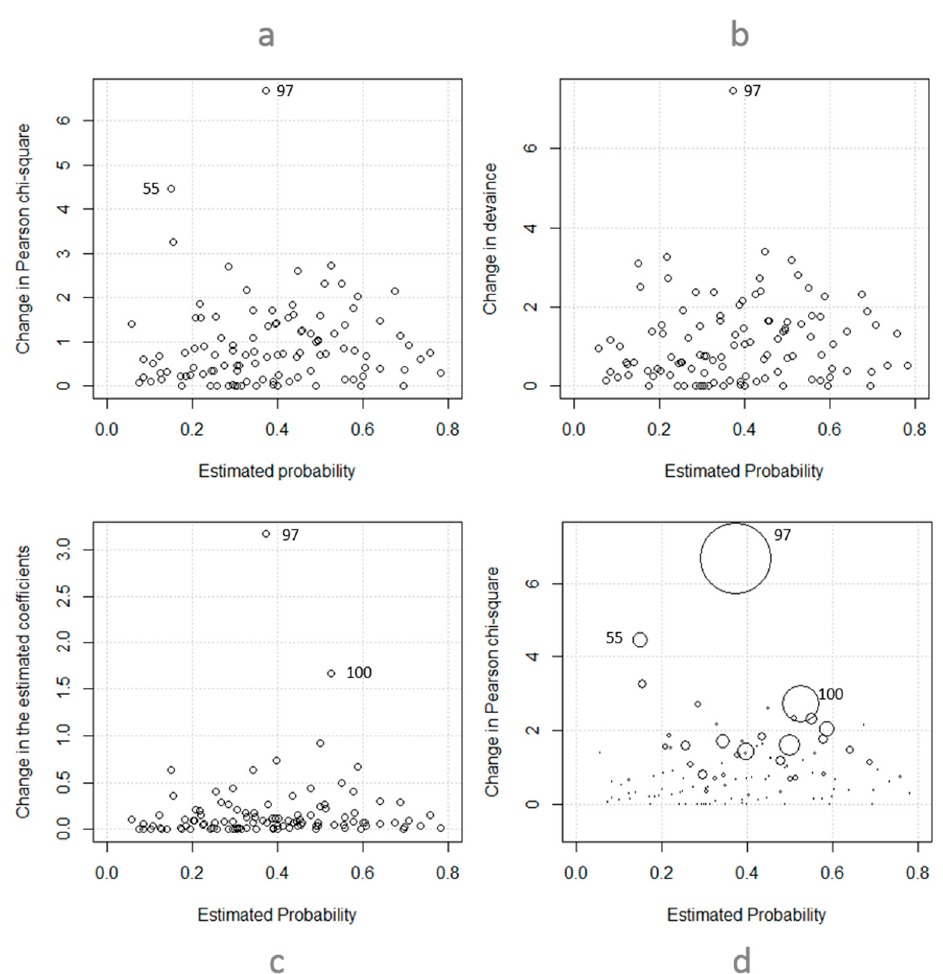
Figure 3. Diagnostic measures for the logistic model, ( a ) Change in Pearson Chi-square when removing individual covariate patterns from data, ( b ) Change in deviance when removing individual covariate patterns from data, ( c ) Change in the estimated coefficients when removing individual covariate patterns from data, ( d ) Combination of a and c: change in Pearson Ci-square (y-axis) and estimated coefficients (size of circles) when removing individual covariate patterns from data. Table 6. Covariate values, observed outcomes (y ijk ), number of cases in the covariate pattern (m ijk ), observed probability (P ijk ), estimated logistic probability ( π ̂ ijk ), and the value of four diagnostic statistics Δχ 2 (i.e., change in value of the Pearson chi-square), Δ D (i.e., change in the deviance), h (i.e., leverage), and Δβ ̂ ( i.e., change in value of the estimated coefficients), for three covariate patterns with at least one large diagnostic value.